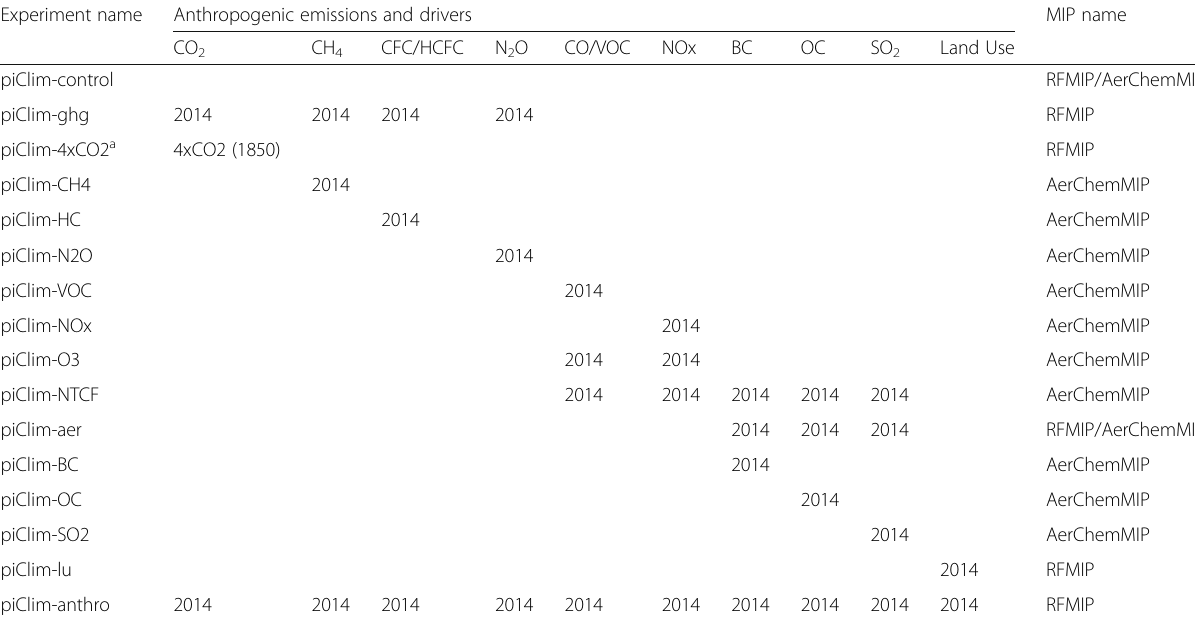
Table 1 Summary of the experiments performed by